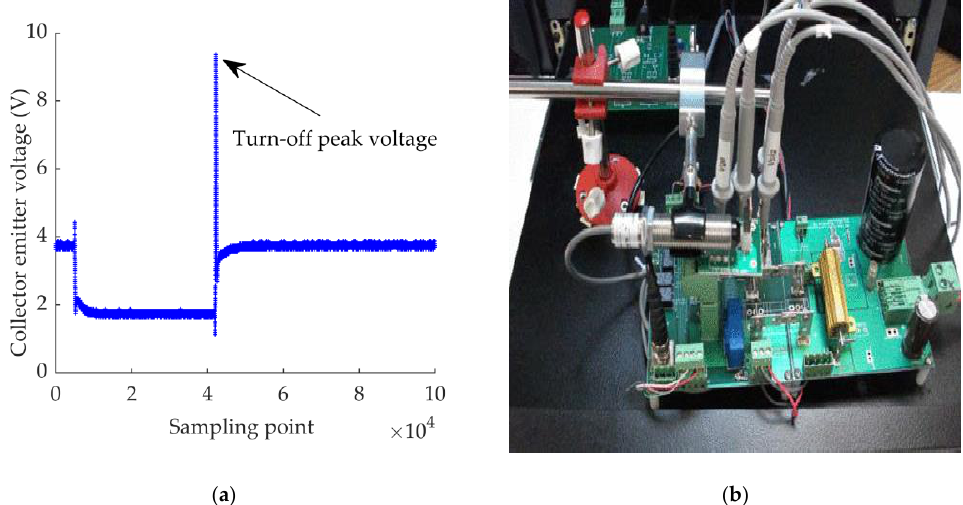
Figure 2. ( a ) Collector–emitter turn-off voltage waveform. ( b ) Insulated gate bipolar transistor (IGBT) accelerated aging experiment platform.